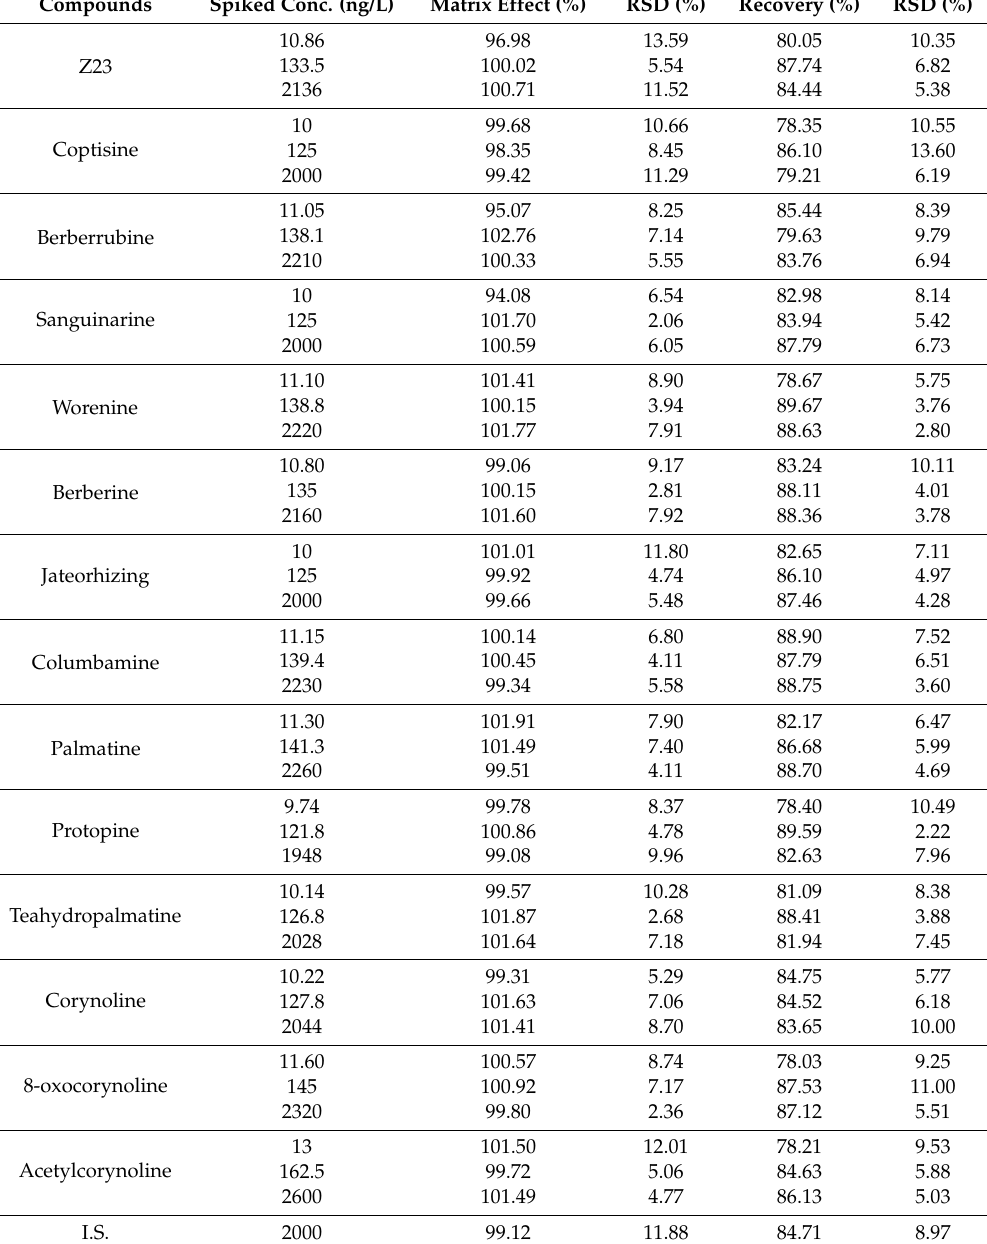
Table 3. Matrix effects and extraction recovery for the analytes in beagle plasma ( n = 6). Compounds Spiked Conc. (ng/L) Matrix Effect (%) RSD